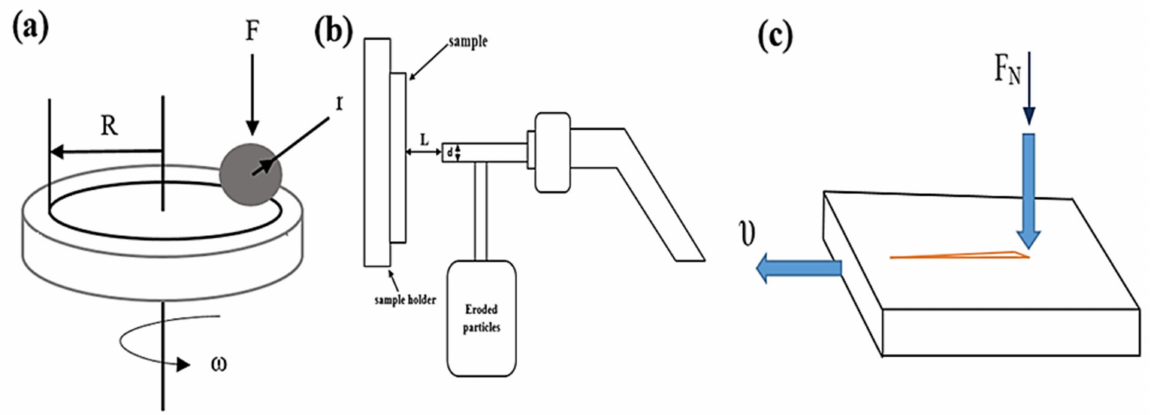
Figure 2. Scheme of testing the coatings for wear resistance ( a ), erosion resistance ( b ) and adhesive strength ( c